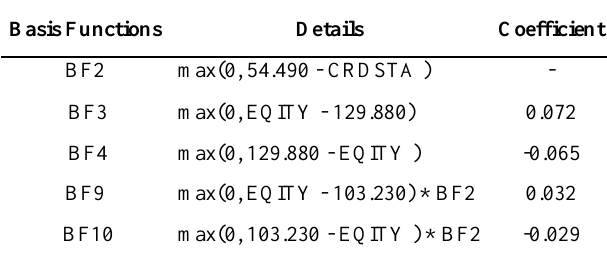
Table 7: Basis Functions of